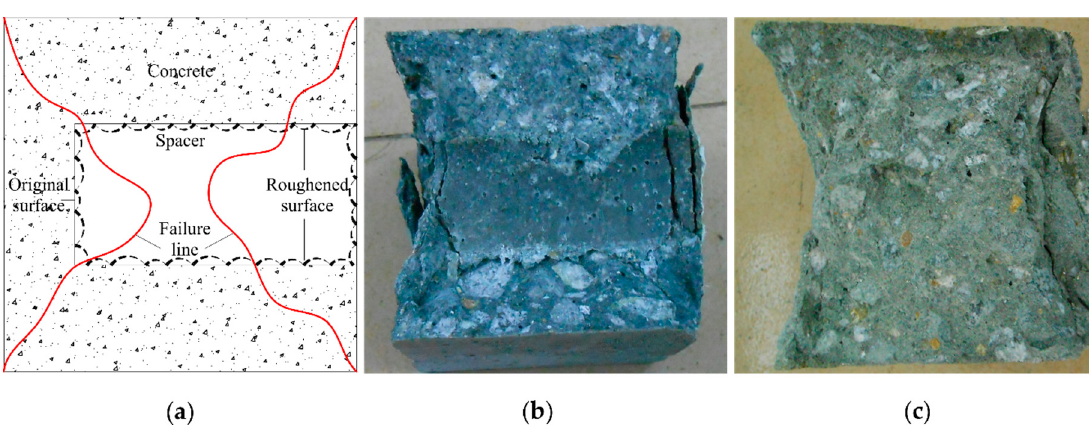
Figure 4. Compressive strengths of the specimens. The control chloride-resistant high-performance concrete was denoted by C. The chloride-resistant small-size coarse aggregate concrete spacers and the chloride-resistant mortar spacers were denoted by SS and MS, respectively. The composite specimen with and without surface treatment were denoted by T and N, respectively.